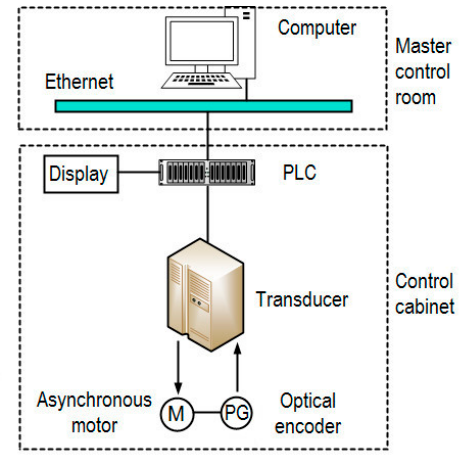
Figure 7. Schematic diagram of belt system control.